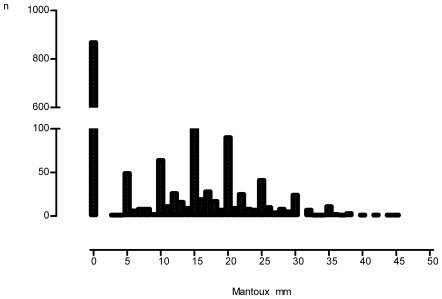
Histogram showing distribution of Mantoux induration diameter (n = 1512) with evidence of reader digit preference at the 5 mm, 10 mm, 15 mm, and 20 mm values.